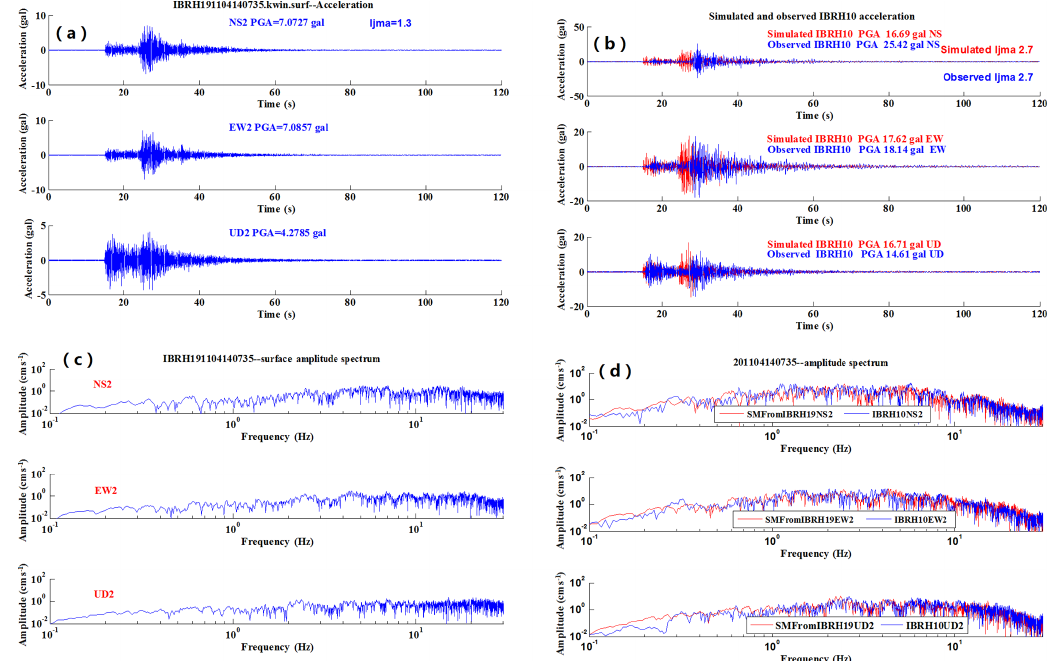
Figure 10. An example of simulation from IBRH19 (surface) to IBRH10 (surface) for the earthquake 201104140735: (a) the observed surface acceleration for IBRH19, (b) the observed surface acceleration waveform (blue) compared with the simulated one (red), (c) the spectral of observed surface record for IBRH19, and (d) the observed spectra of surface record at IBRH10 (blue) compared with the simulated one (red).